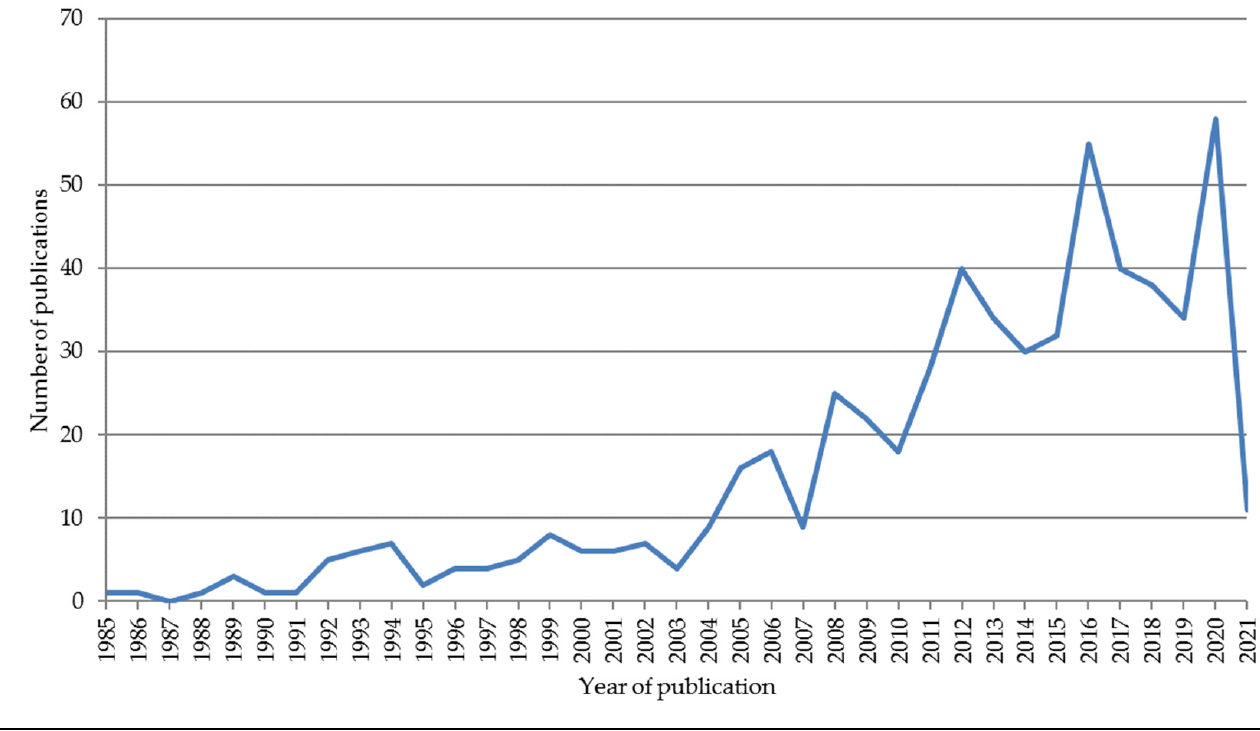
Figure 1. Publications over time on Competitive Intelligence (n = 589). Source: Prepared by the authors on the basis of WoS data.